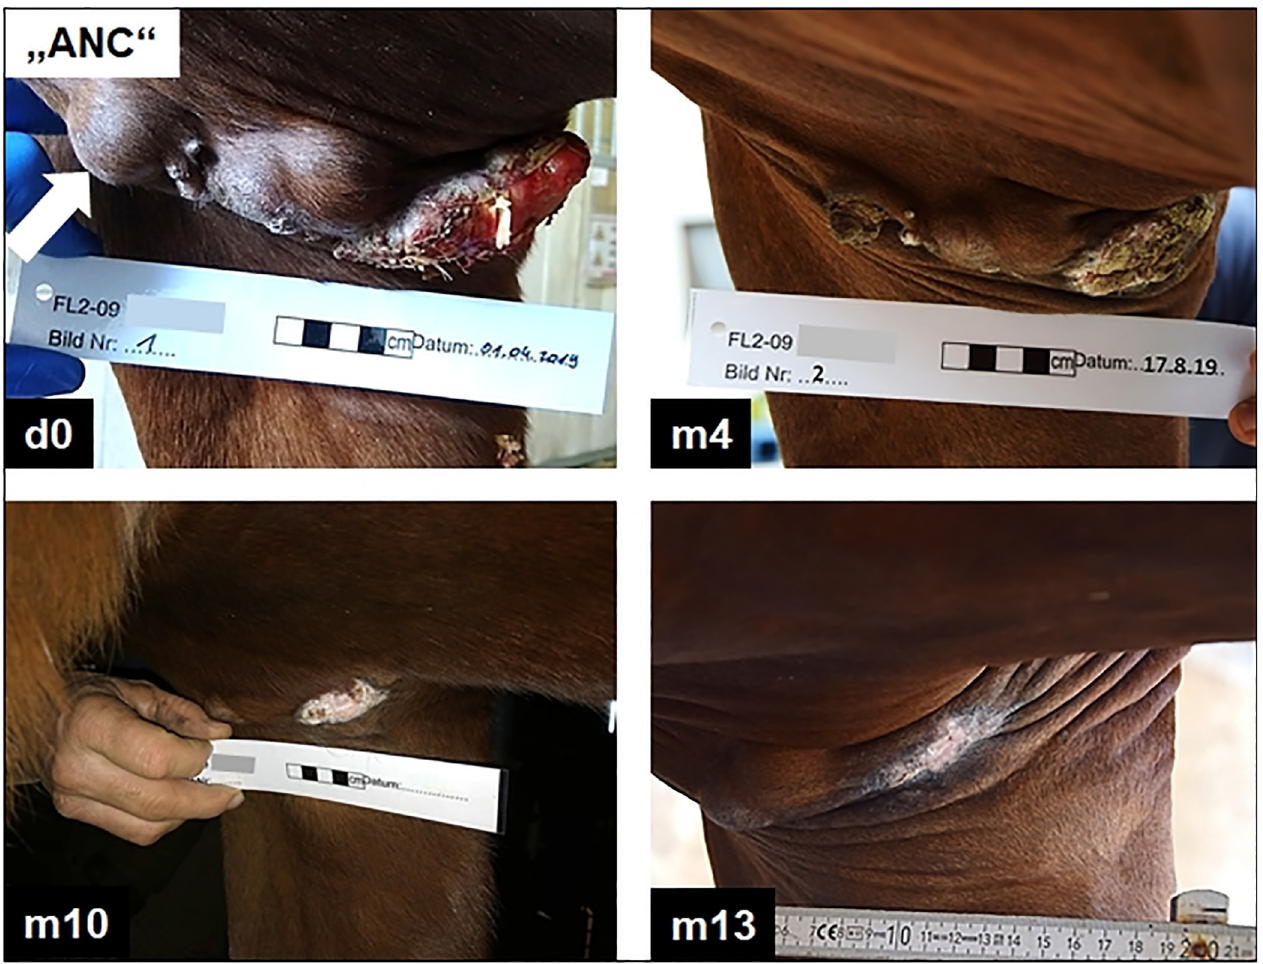
Fig 5. Intratumoural injection with iNSA/E6E7 equ and/or iNSB/E6E7 equ led to tumour regression even in equine patients with severe disease. A mare (ANC) with multiple, severe-type sarcoids affecting the right axilla, abdomen and inner thigh responded to intratumoural therapy. Injection of a single lesion with iNSA/E6E7 equ on days 0, 2 and 4, and iNSB/E6E7 equ on days 7, 9 and 11 by (white arrow indicates injection site) led to complete regression of the injected and all non-injected sarcoids within 13 months as exemplarily shown for the right axilla. d0: day 0; m4: month 4; m10: month 10; m13: month 13.